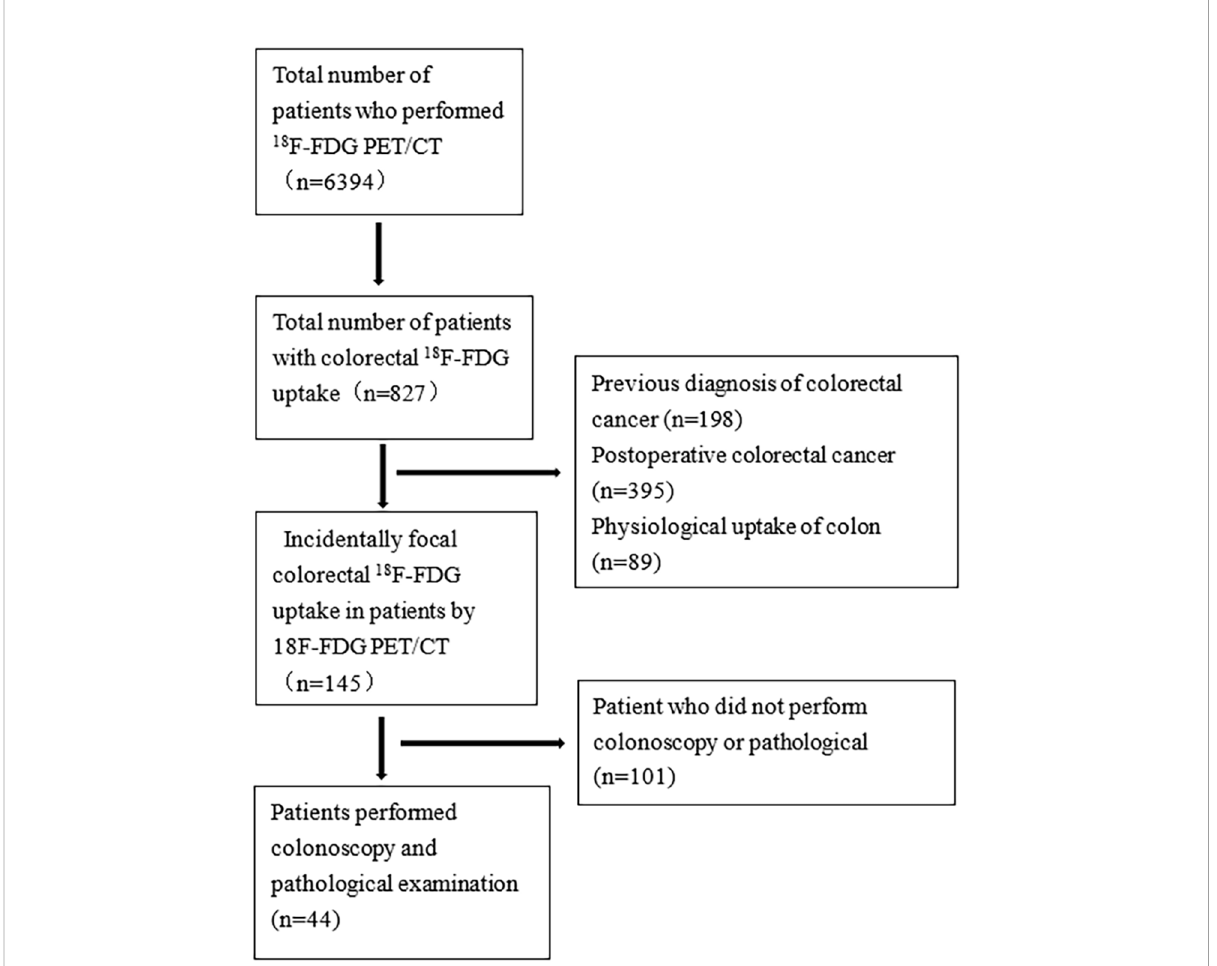
FIGURE 1 Screening process for patients with incidental focal colorectal 18 F-FDG uptake